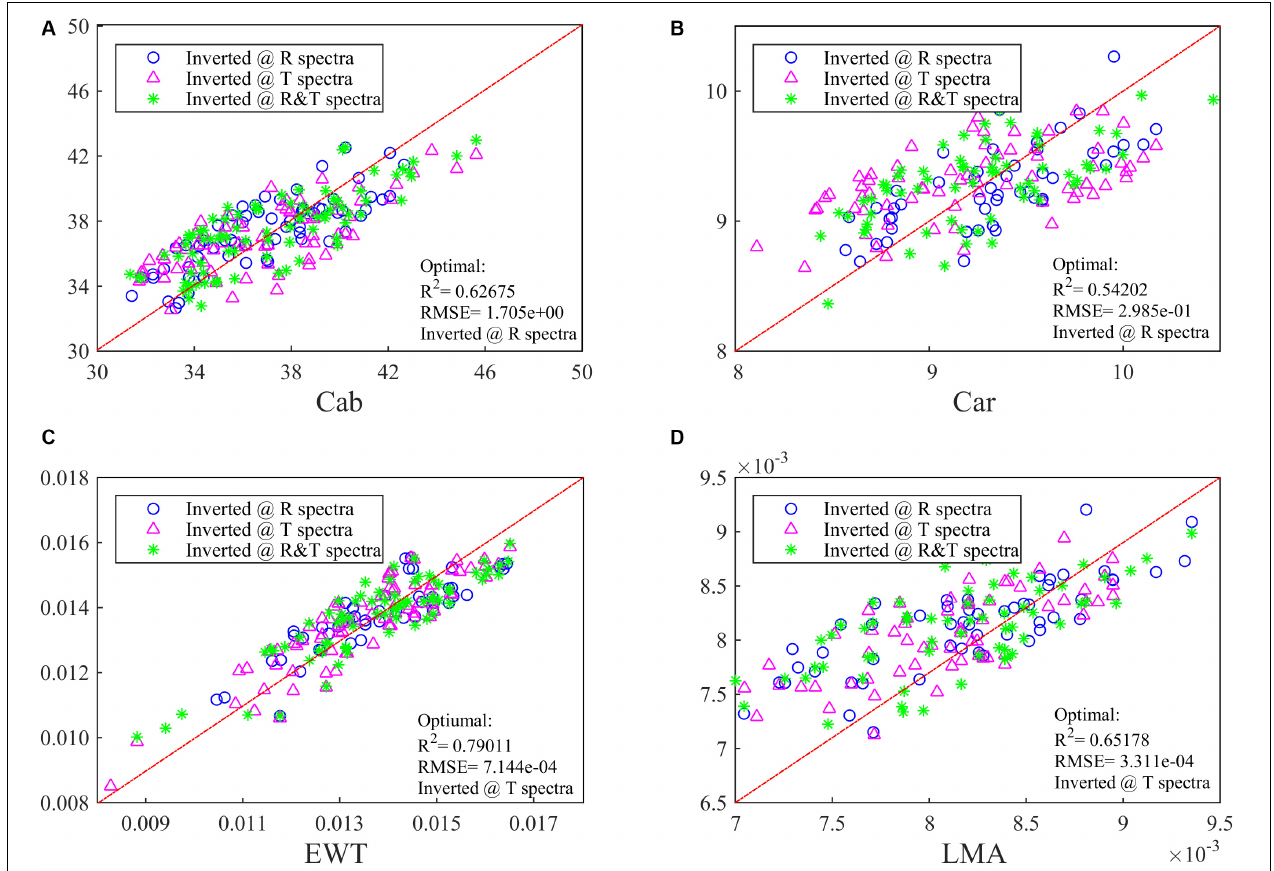
FIGURE 2 | The inversion R 2 for (A) Cab, (B) Car, (C) EWT, and (D) LMA in the synthetic database by using PLSR. Different spectra (i.e., R, T, and R&T) are used and the optimal R 2 has been added in the lower right of the